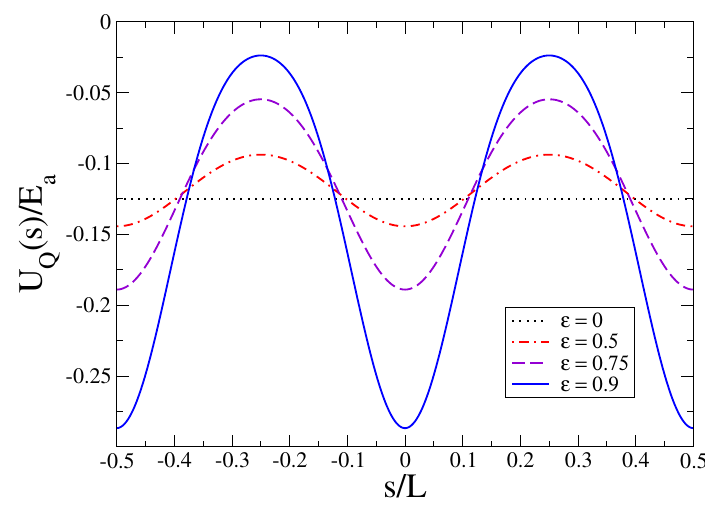
( s ) , Eq. (6), induced by the geodesic cur- Q = ħ h 2 / ( ma 2 ) a a